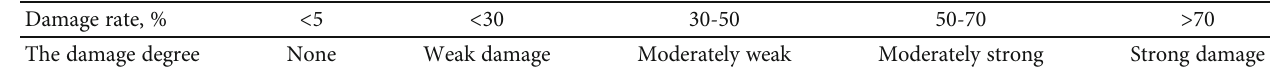
Table 2: The evaluation indexes of fracturing fl uid damage